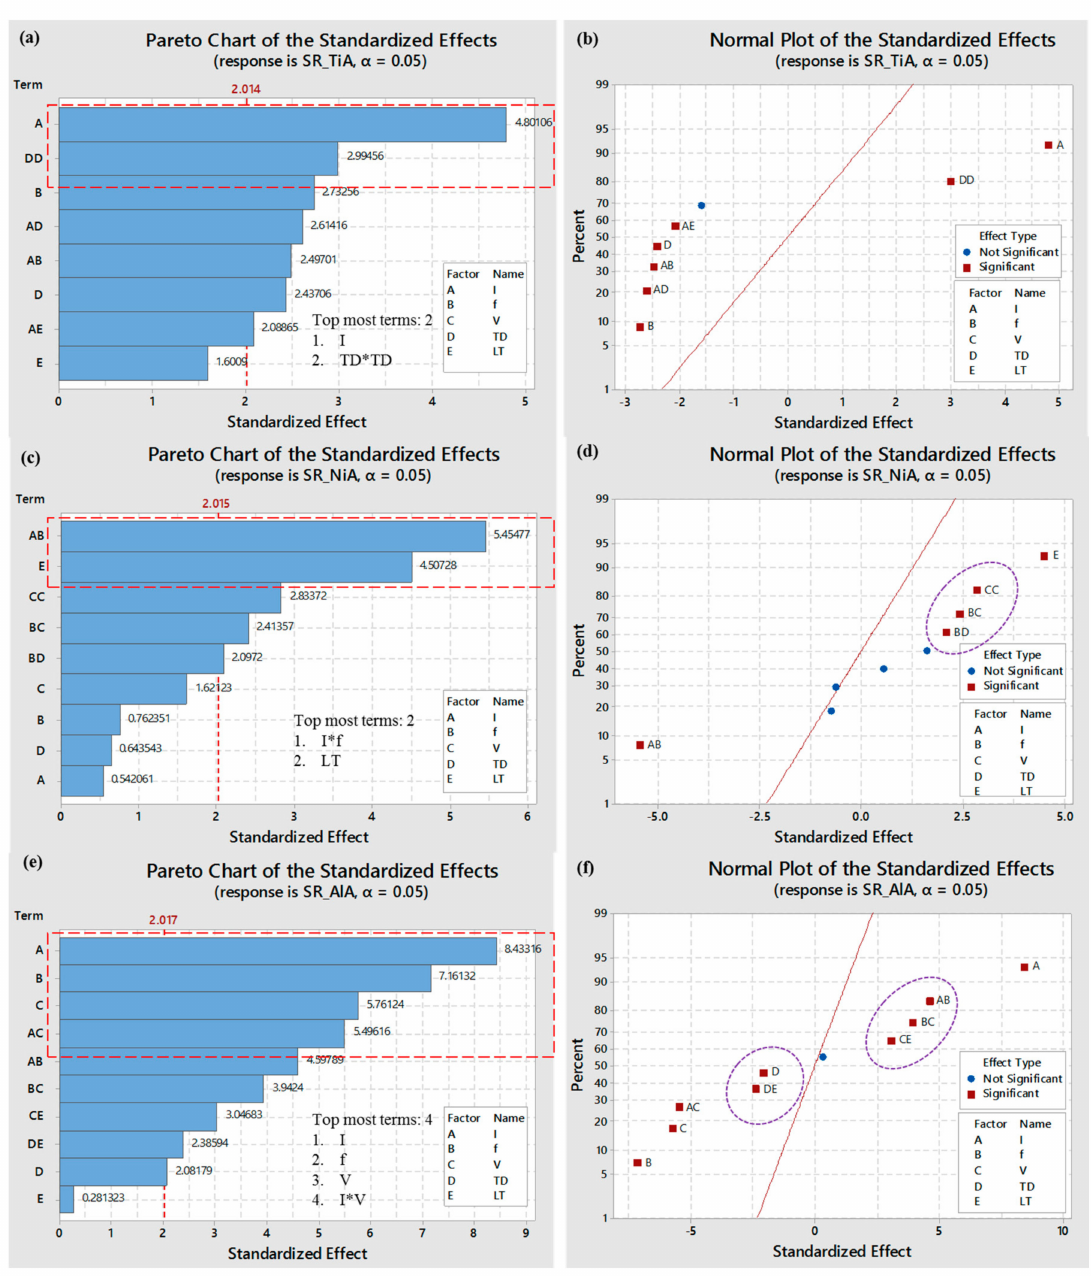
Figure 8. Standardized e ff ects of laser parameters; ( a ) Pareto chart for TiA, ( b ) normal plot for TiA, ( c ) Pareto chart for NiA, ( d ) normal plot for NiA, ( e ) Pareto chart for AlA, and ( f ) normal plot for